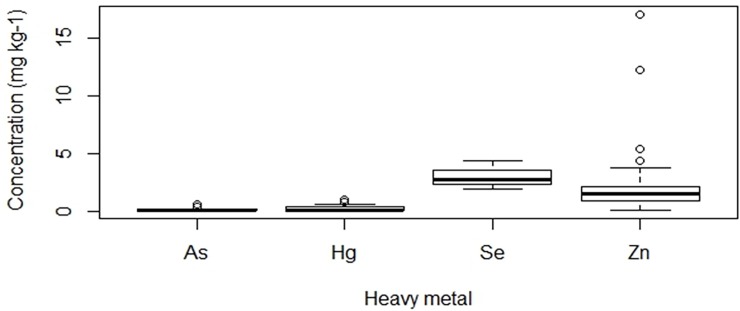
Trends in the concentration of heavy metals in the muscle tissues of Brachydeuterus auritus from the coastal waters of Ghana.Note: Pb, Cd and Cu were below detection limits in B. auritus. Also, pairwise comparison indicates concentration of all metals were significantly different except As and Hg (Kruskal-Wallis test with Fisher’s LSD post hoc, H3,0.05 = 129.618, p < 0.05.